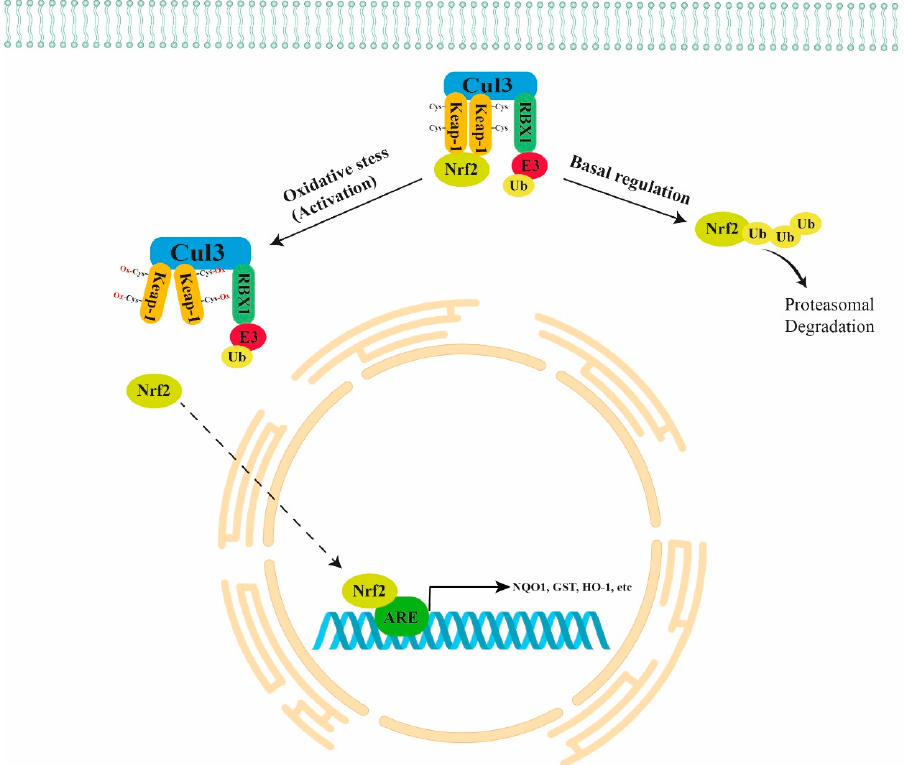
Figure 1. Schematic representation of NRF2 regulation. Normally, NRF2 is directly bound to the KEAP1/CUL3/RBX1 E3-ubiquitin ligase complex that targets NRF2 for proteasomal degradation. Under oxidant stimuli, ROS oxidate the cysteine residues of KEAP1 leading to a conformation change in KEAP1 that causes the inhibition of NRF2 ubiquitination and its translocation into the nucleus with consequent binding to the ARE regions of antioxidant genes (NQO1, GST, HO-1, etc.). KEAP1 = Kelch-like ECH Associated Protein 1; CUL3 = Cullin 3; RBX1 = RING-box protein